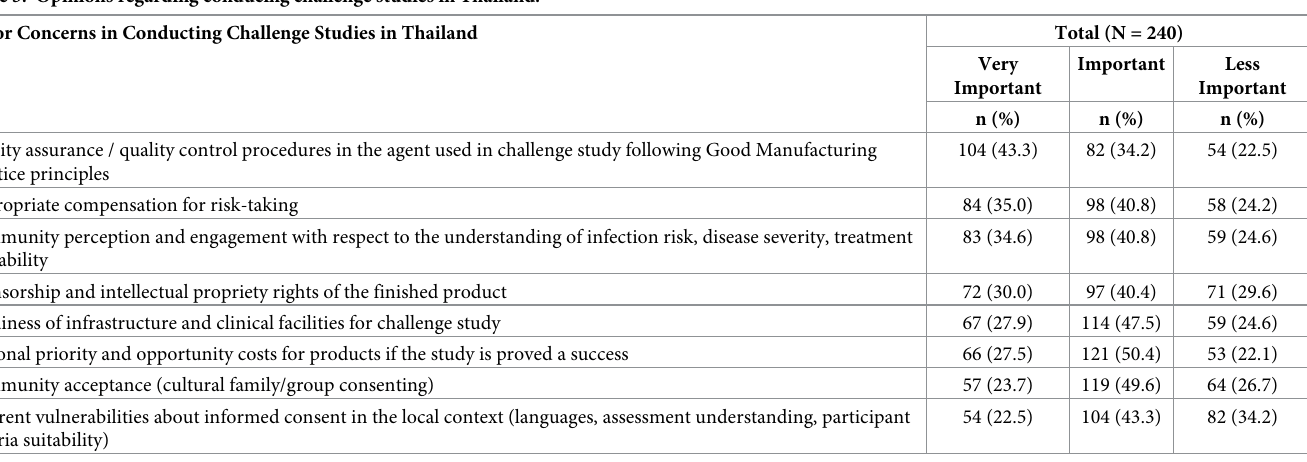
Table 5. Opinions regarding conducing challenge studies in